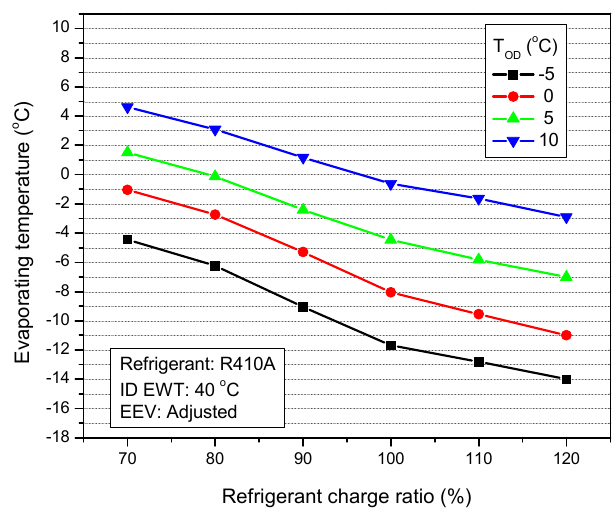
Figure 14. Variation of evaporating temperature with refrigerant charge ratio and T OD .